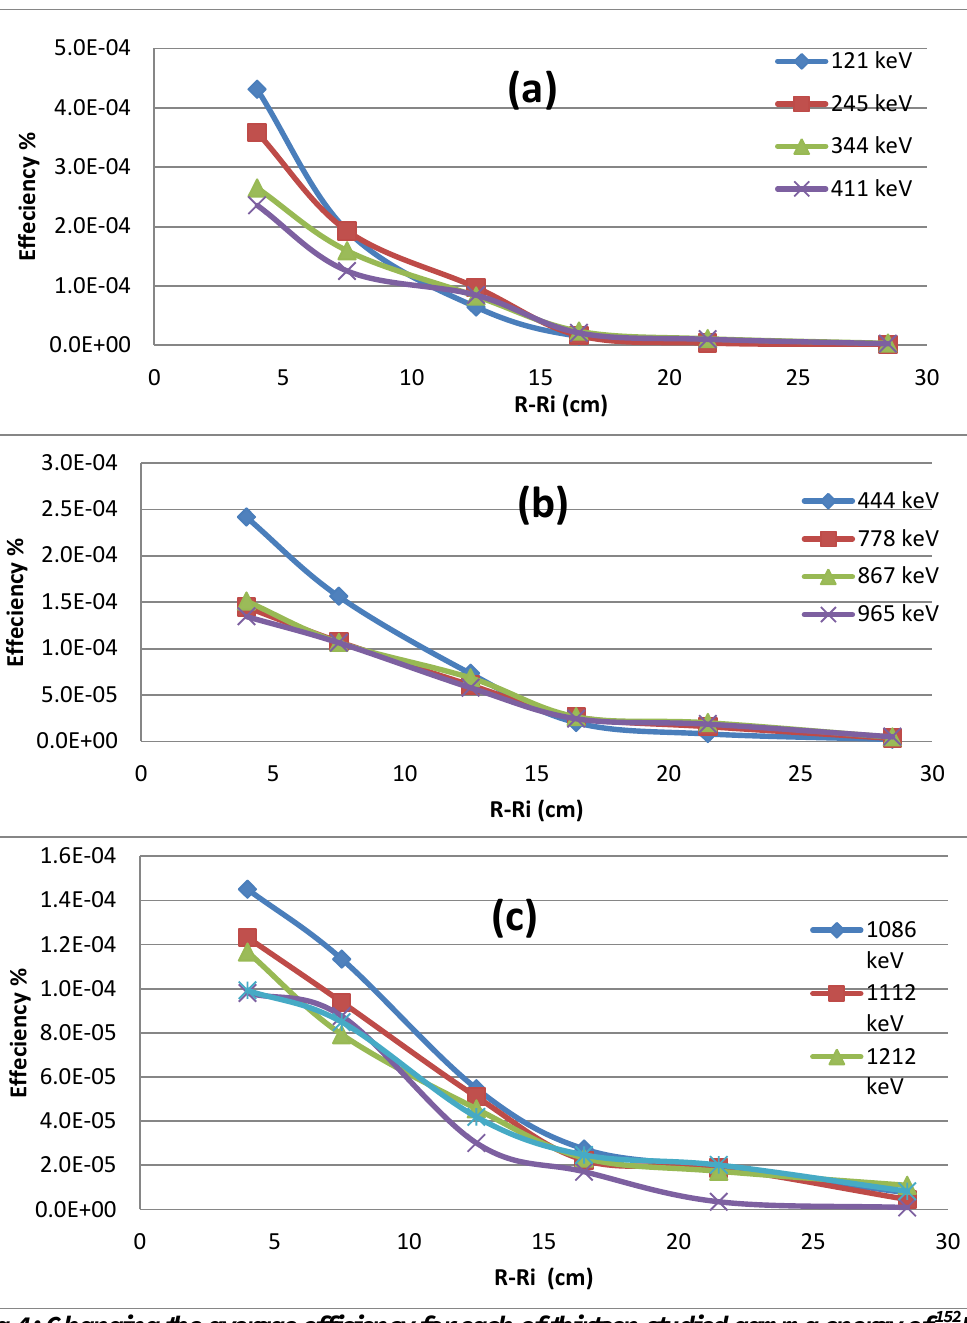
Fig.4: Changing the average efficiency for each of thirteen studied gamma energy of 152 Eu (a, b and c) at specified volume with radius (R- Ri), (without